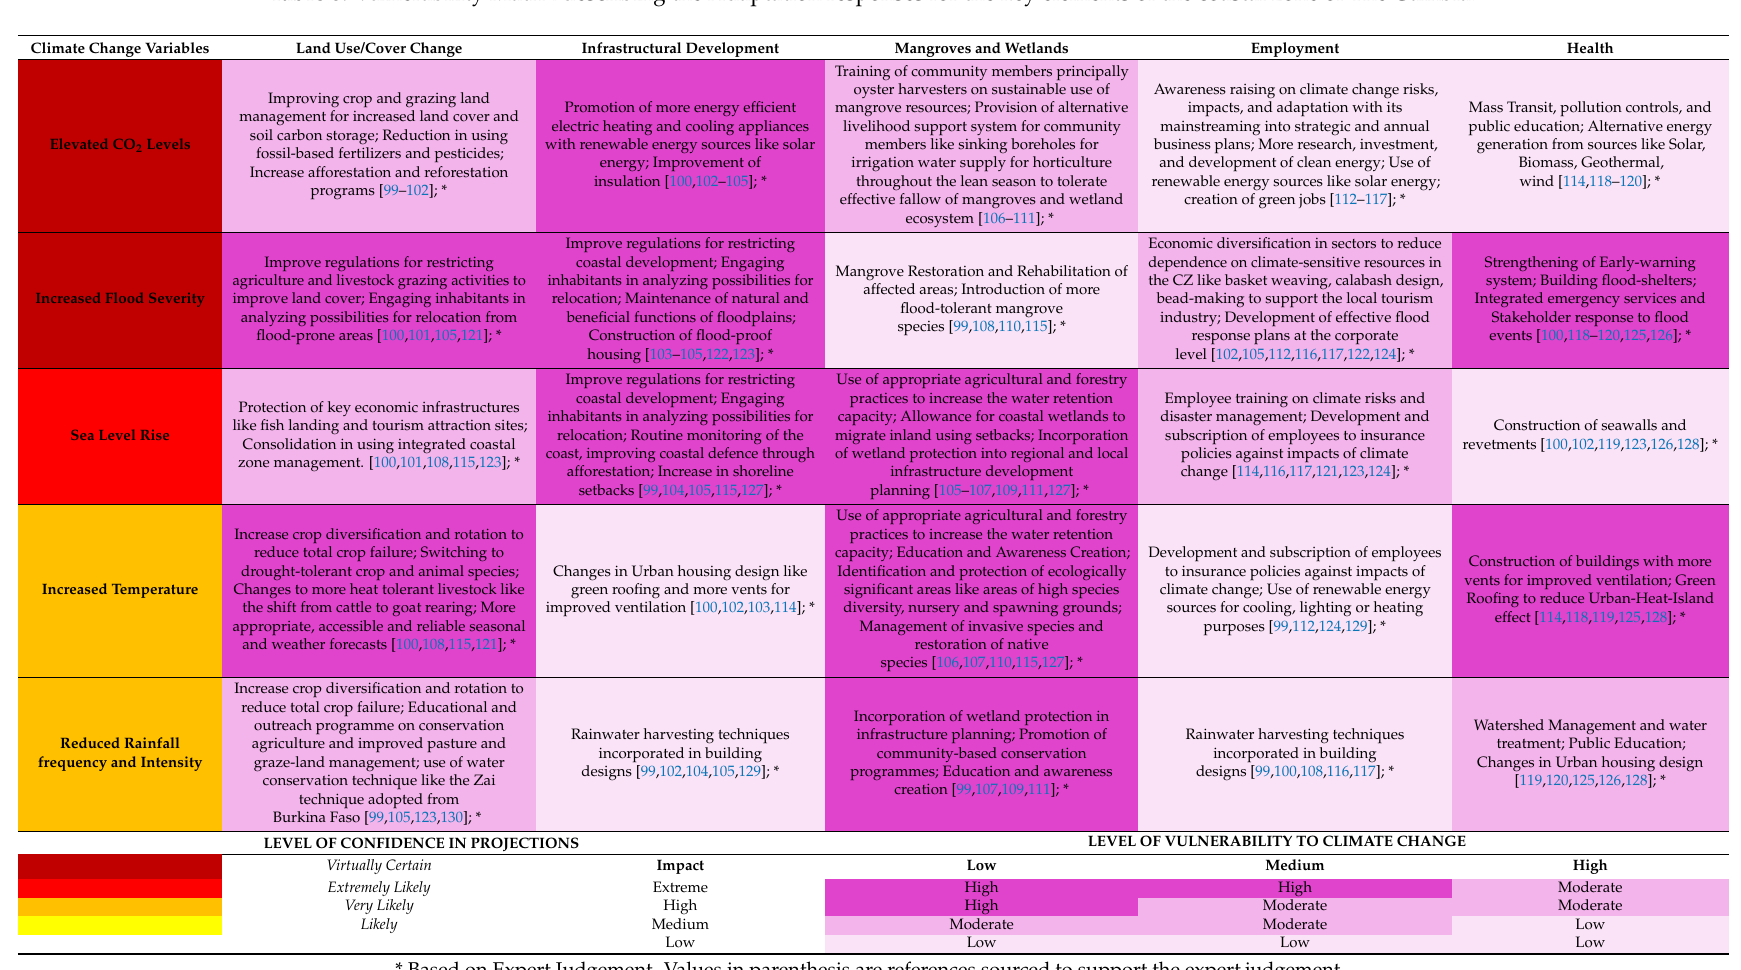
Table 8. Vulnerability Matrix describing the Adaptation responses for the key elements of the coastal zone of The